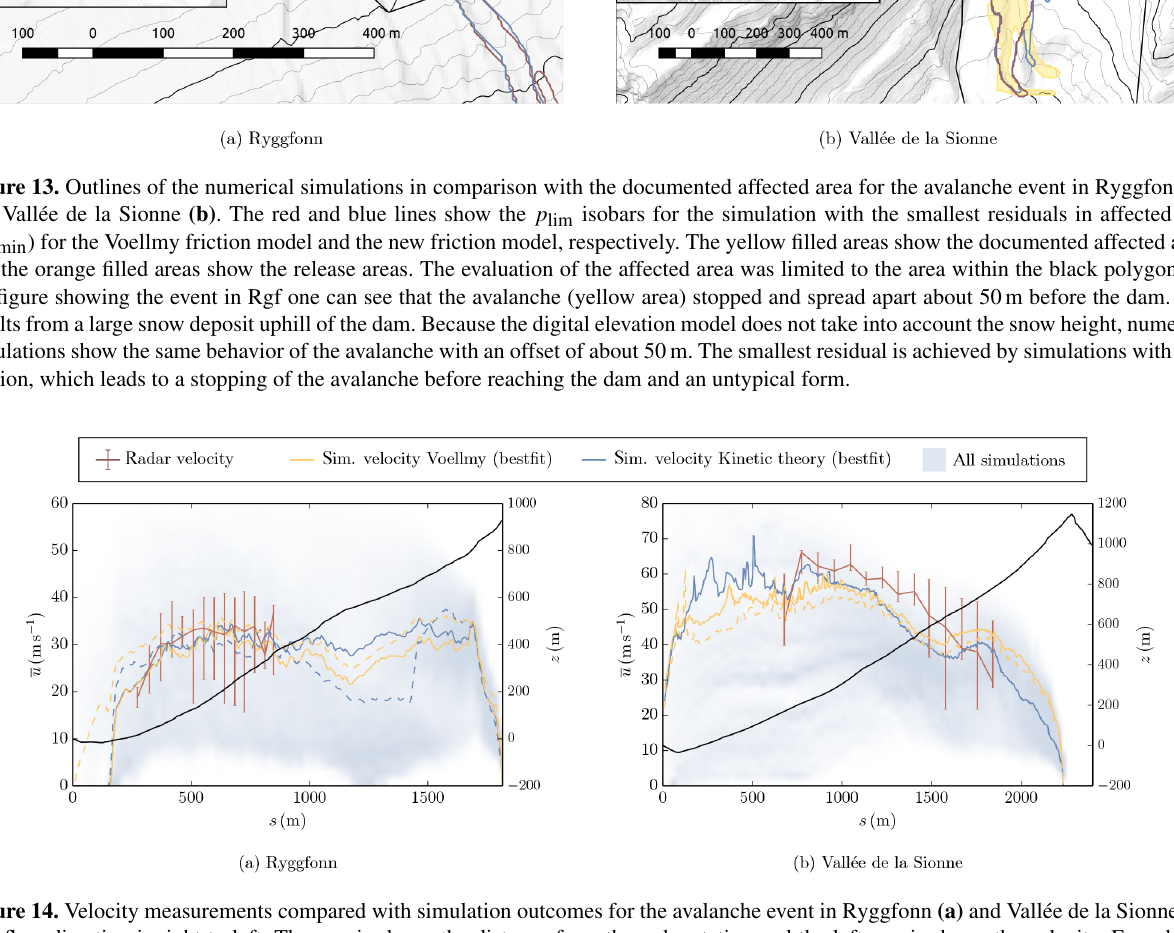
Figure 14. Velocity measurements compared with simulation outcomes for the avalanche event in Ryggfonn (a) and Vallée de la Sionne (b) . The flow direction is right to left. The x axis shows the distance from the radar station and the left y axis shows the velocity. For a better orientation the elevation profile is shown in black and the right y axis shows the elevation. The red line shows the velocity obtained by the pulsed Doppler radar measurements with an estimated observational error. The yellow and blue lines show the velocity along the radar path in the simulation with the smallest residual for the Voellmy friction model and the new friction model, respectively. The dashed lines show the best simulation when using the same material parameter for both events. For the kinetic theory friction model the optimized parameter set for VdlS and both events combined coincide. The background shows the distribution of velocities obtained by all